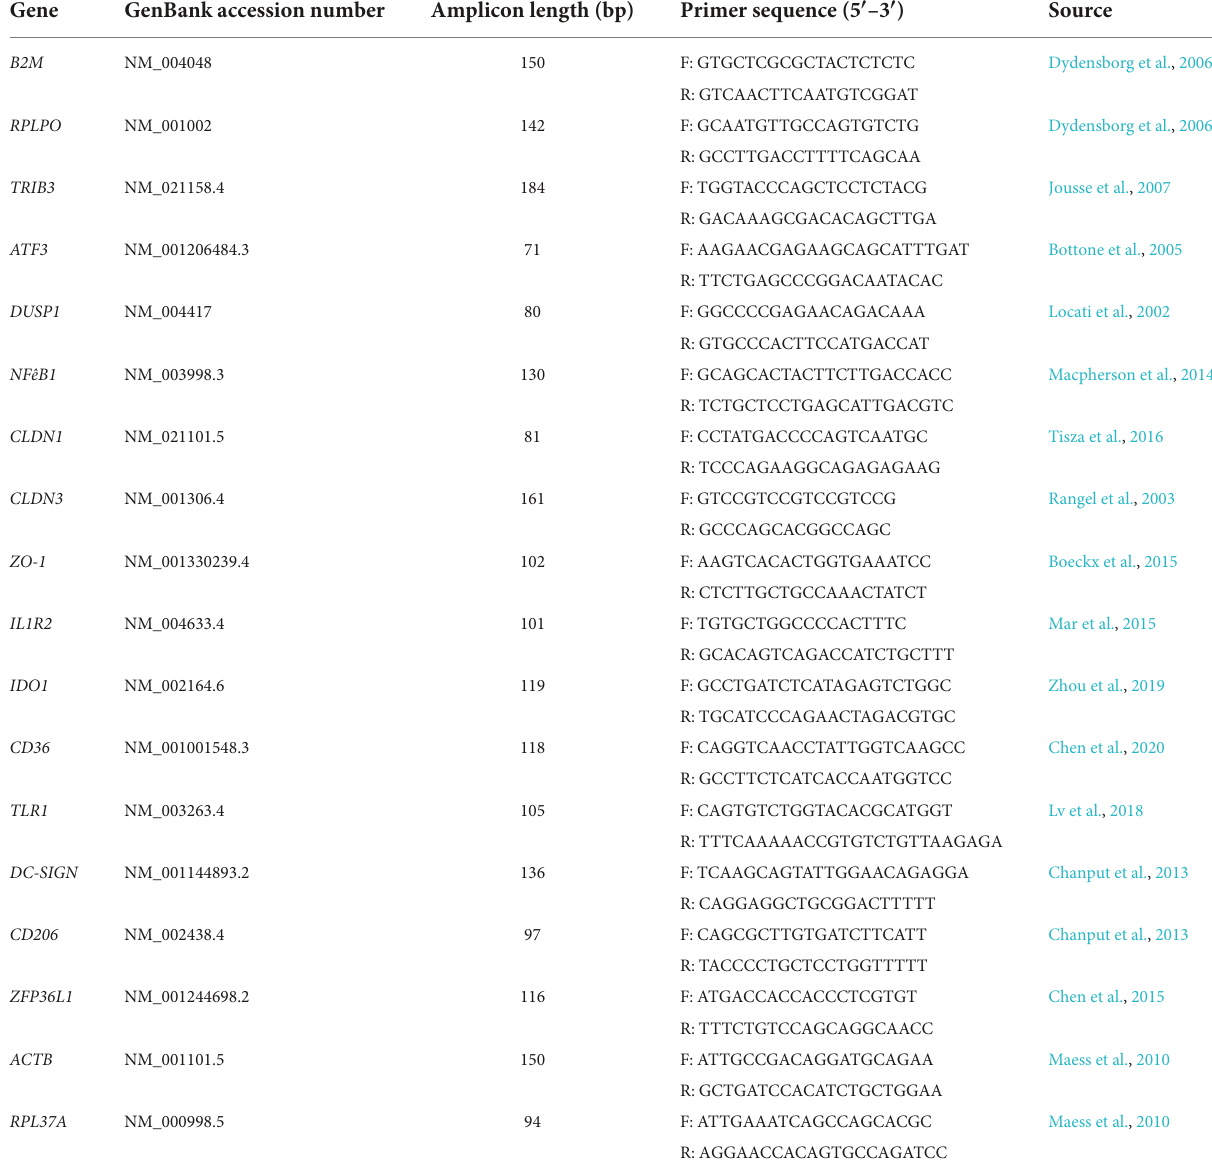
TABLE 1 List of primers used for relative RT-qPCR for determination of gene expression profiles in T84 IECs and THP-1 monocyte co-cultures. Gene GenBank accession number Amplicon length